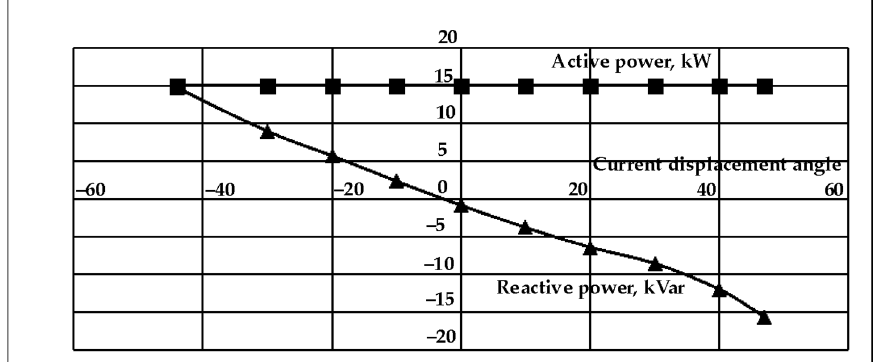
Figure 13. Active and reactive power at the point of the 15 kW MC-based VFD connection to 0.4 kW power distribution lines as a function of the current displacement angle determined by ISVM.